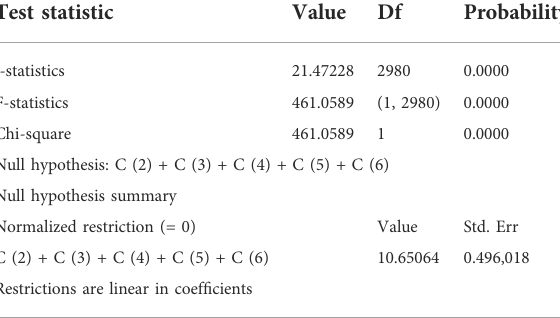
TABLE 3 Gradients of the objective